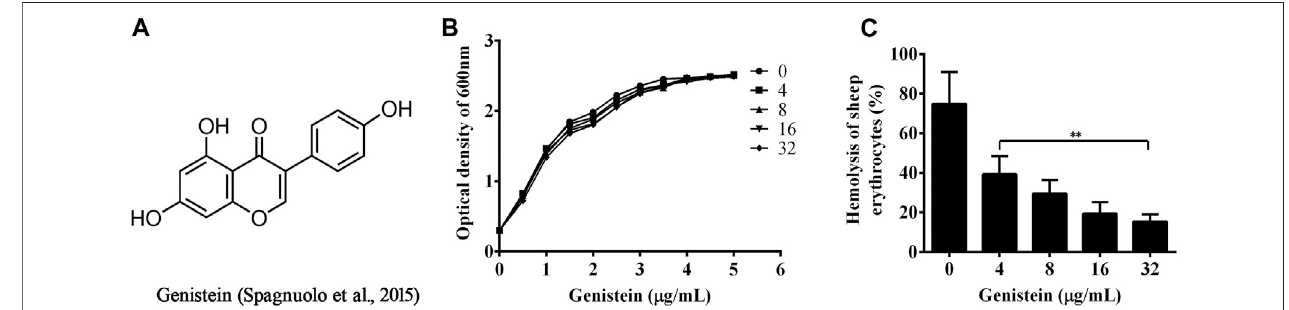
FIGURE1| Inhibitoryeffectsofgenisteinonhemolytic activity ofbacterialsupernatantsco-culturedwithgenistein. (A) ,chemicalstructure ofgenistein; (B) ,Growth curvesof A.hydrophila XS-91-4-1plusindicatedconcentrationsofgenistein; (C) ,genisteininhibitshemolyticactivityofbacterialsupernatantsco-culturedwithgenistein, 1% Triton X-100 treated red blood cells represented 100% hemolytic activity, three independent hemolytic assays were performed and data in Figure 1C were mean value ± SD, * p < 0.05 and ** p < 0.01 when compared with the genistein-free